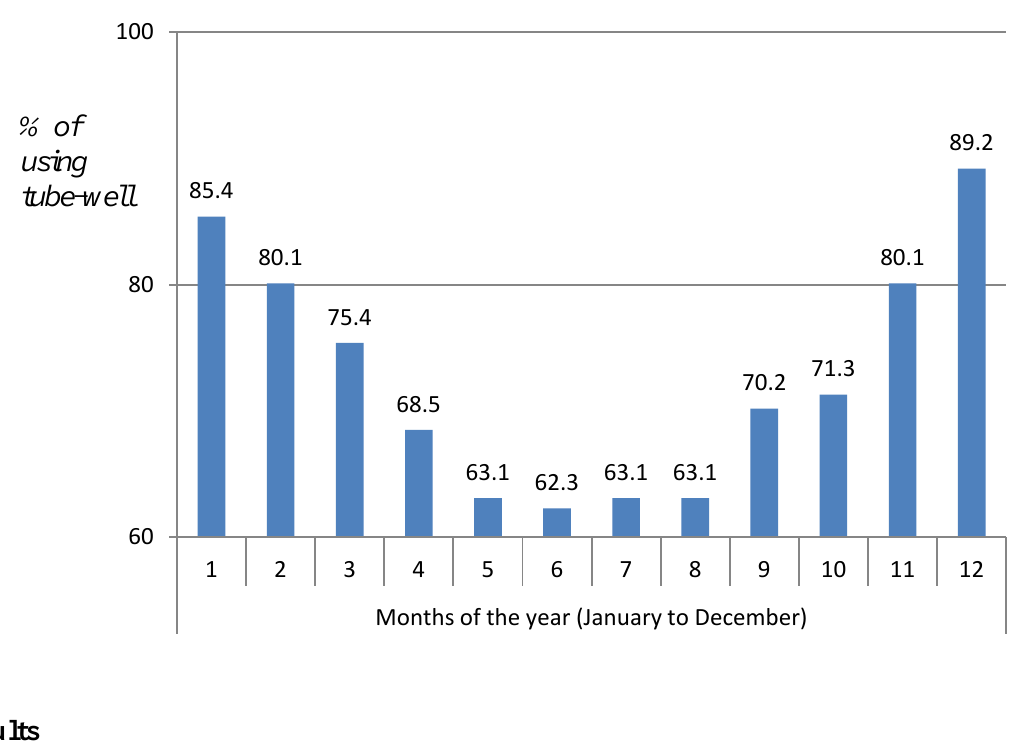
Figure 2. Status of tube-wells used for drinking purposes during one